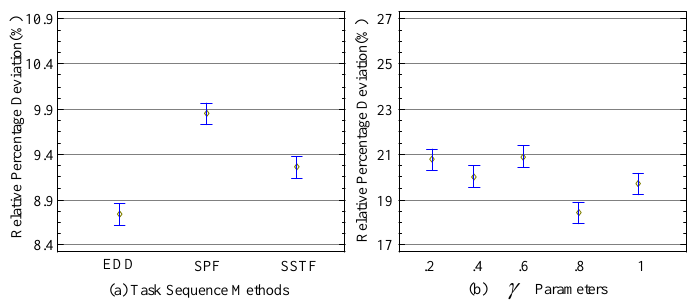
Figure 5. Task sequencing Tightness Rules With Different